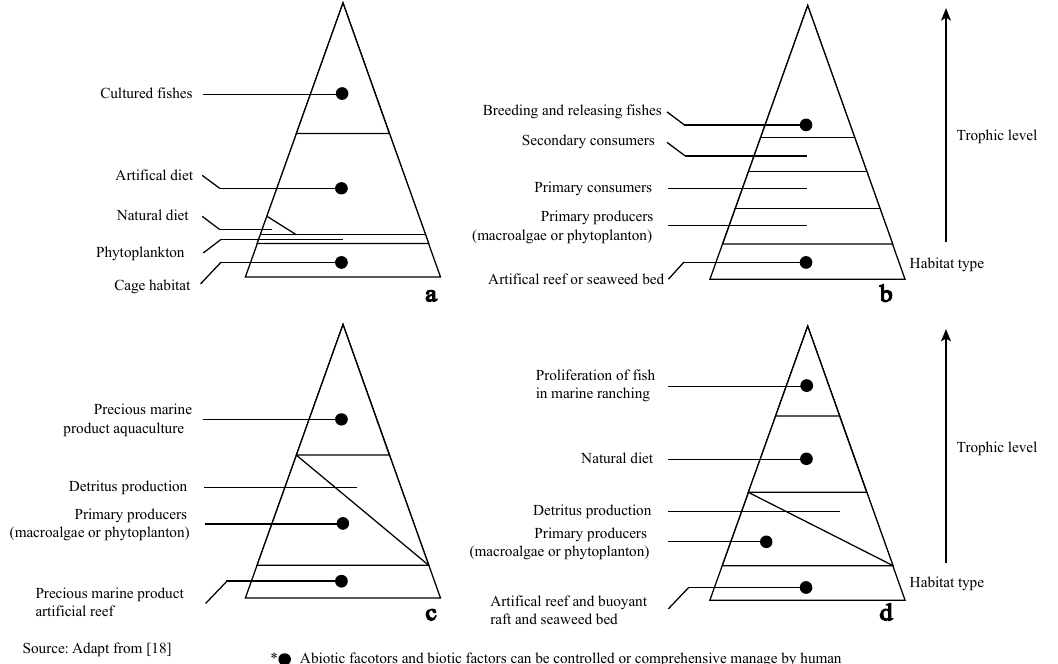
Figure 4. Typical marine ranching habitat construction mode in the ECS: ( a ) cage aquaculture mode, ( b ) traditional stock enhancement and releasing mode, ( c ) integrated multi-trophic aquaculture (IMTA) mode, and ( d ) multi-trophic and spatial based marine ranching mode [18].